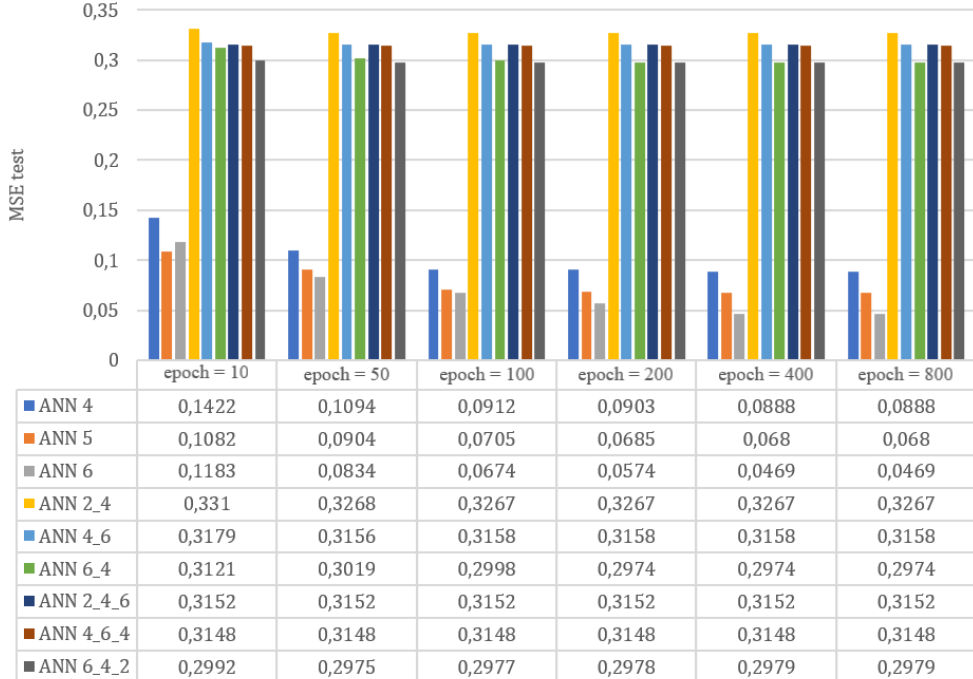
Figure 10. MAE train results of nine different ANN topologies.